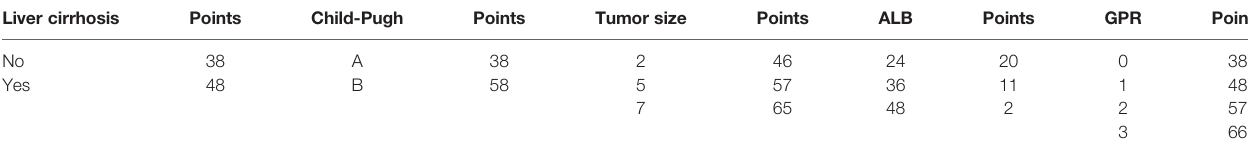
TABLE 4 | OS nomogram scoring